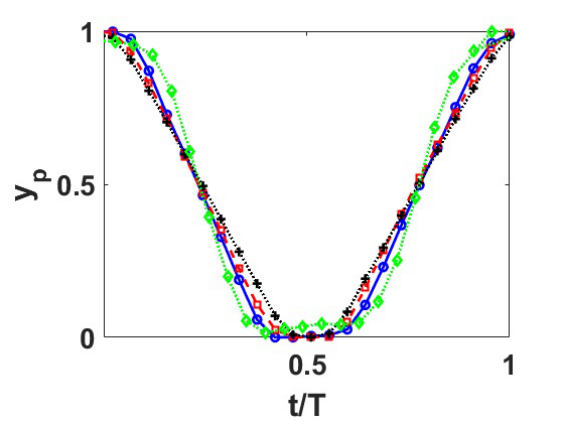
Figure 2: Normalized displacement of piston y p for Re u =505 (diamond green), Re u =820 (blue circles), Re u =1187 (red squares), Re u =1625 (black plus